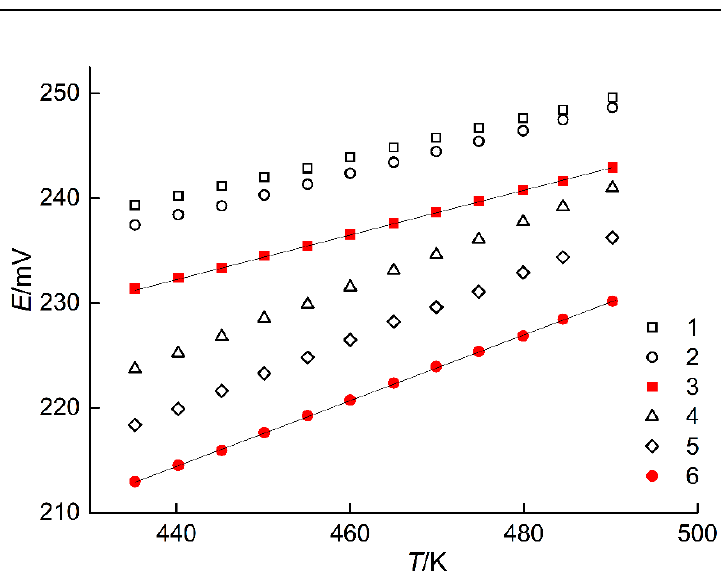
Figure 3. Dependences E vs. T of the ECCs constituting positive electrodes of phase assemblages: FeTe 2 –Fe 1.12 Te–AgFeTe 2 (1), Ag 2 Te–FeTe 2 –AgFeTe 2 (2), FeTe 2 –AgFeTe 2 (3), Ag 2 FeTe 2 –Fe 1.12 Te–